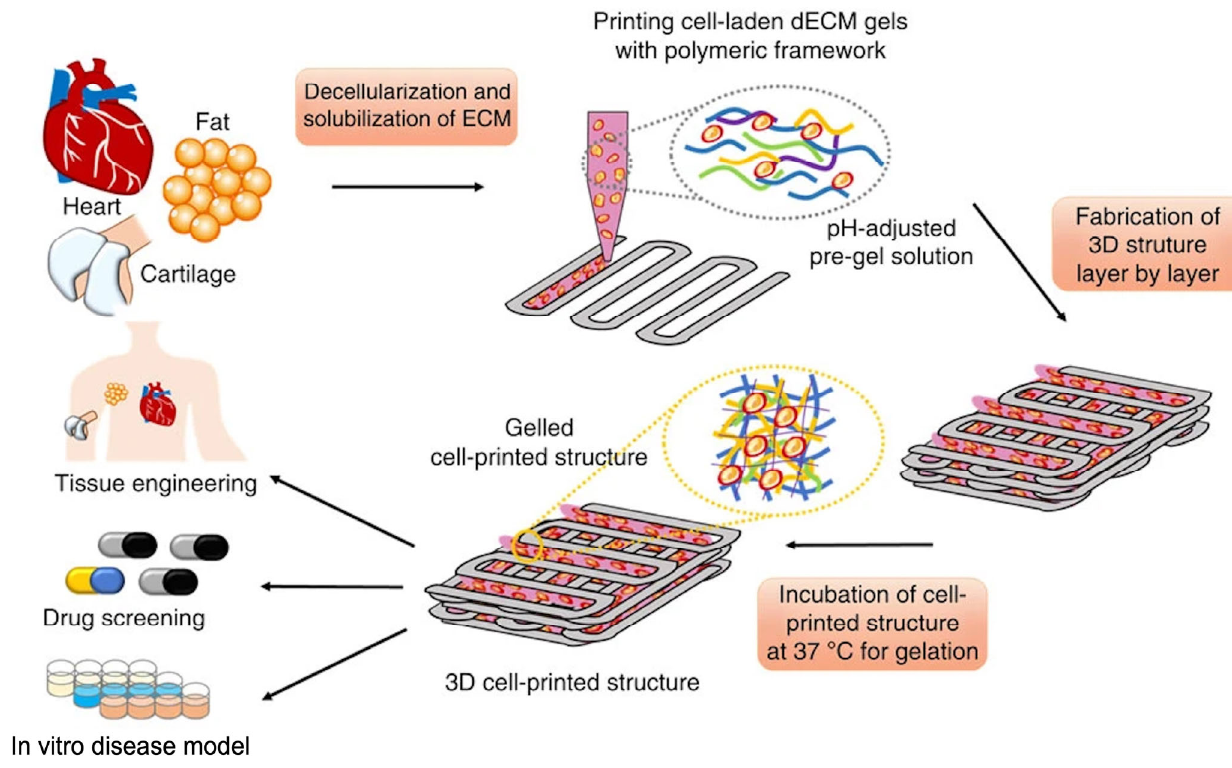
Figure 7. The process of using dECM-based bioink to fabricate dECM-based scaffolds [142] .